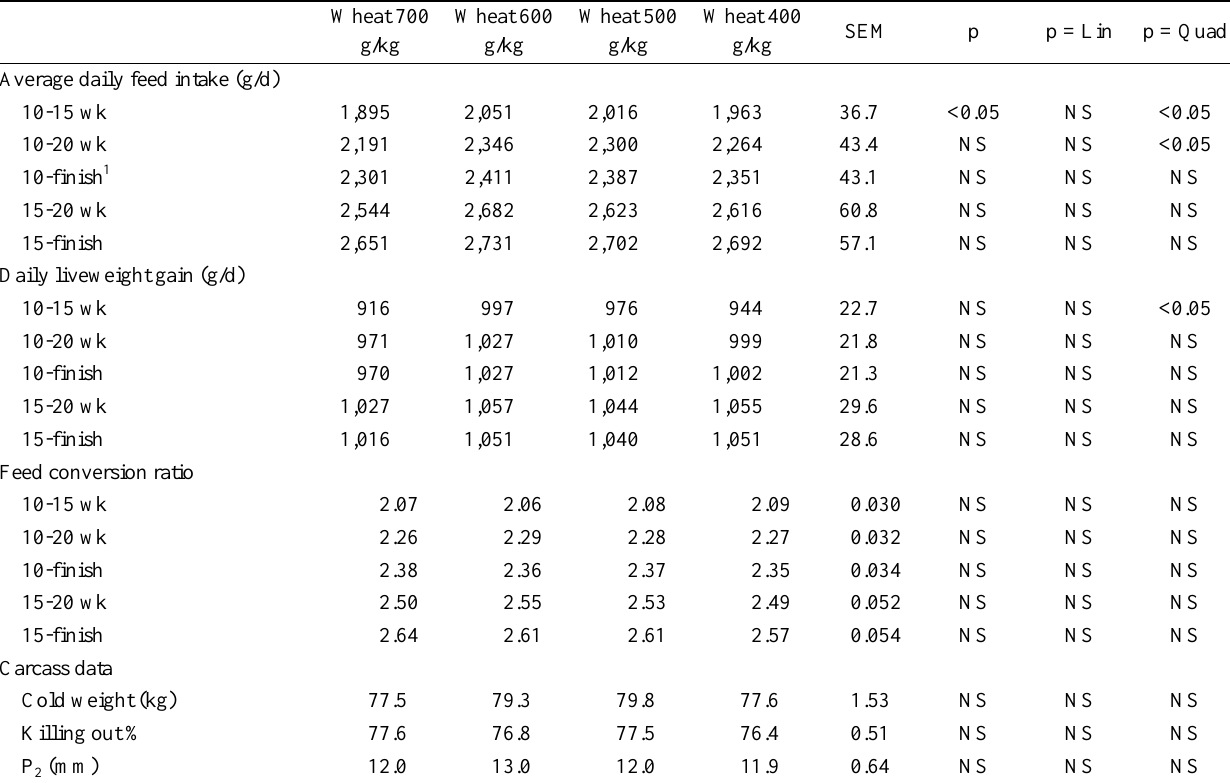
Table 2. The effect of dietary inclusion level of wheat on performance of individually housed